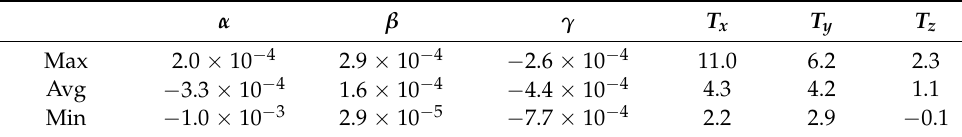
Table 3. GPA-ICP registration